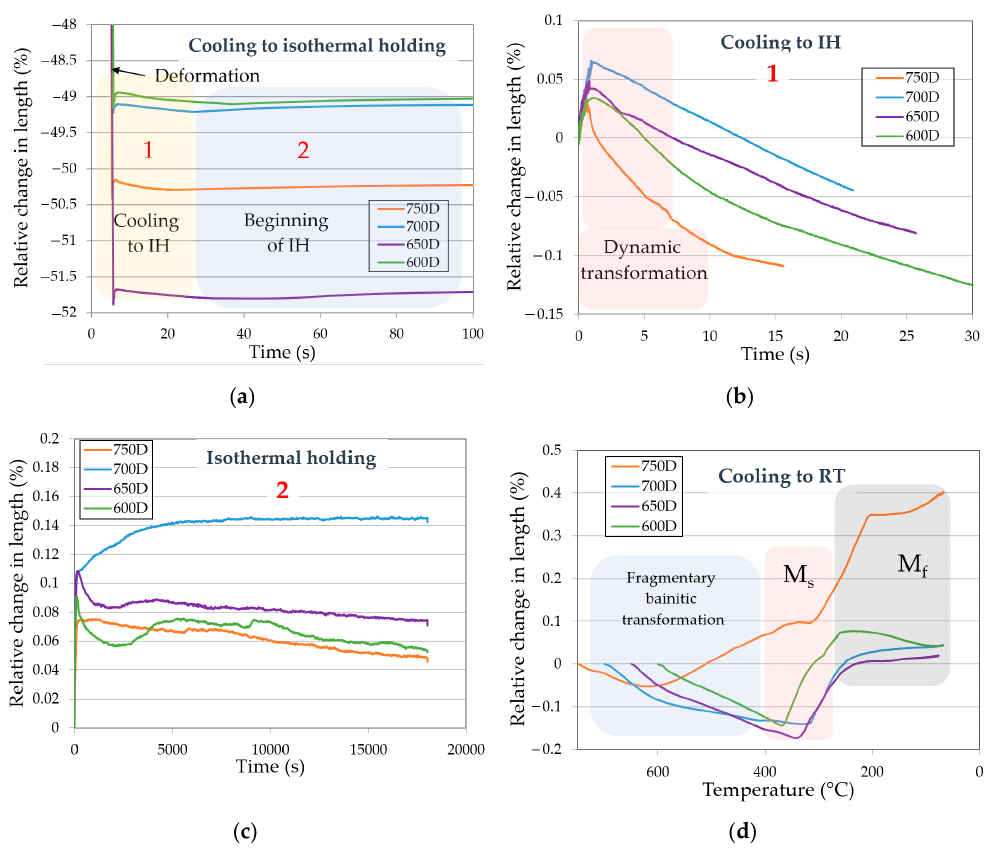
Figure 5. Dilatometric curves of deformed samples: ( a ) cooling from deformation to isothermal holding; ( b ) cooling from deformation to isothermal holding—magnification; ( c ) isothermal holding step; ( d ) cooling to room temperature; IH—isothermal holding; RT—room temperature. Table 4. Experimental results of deformed samples.